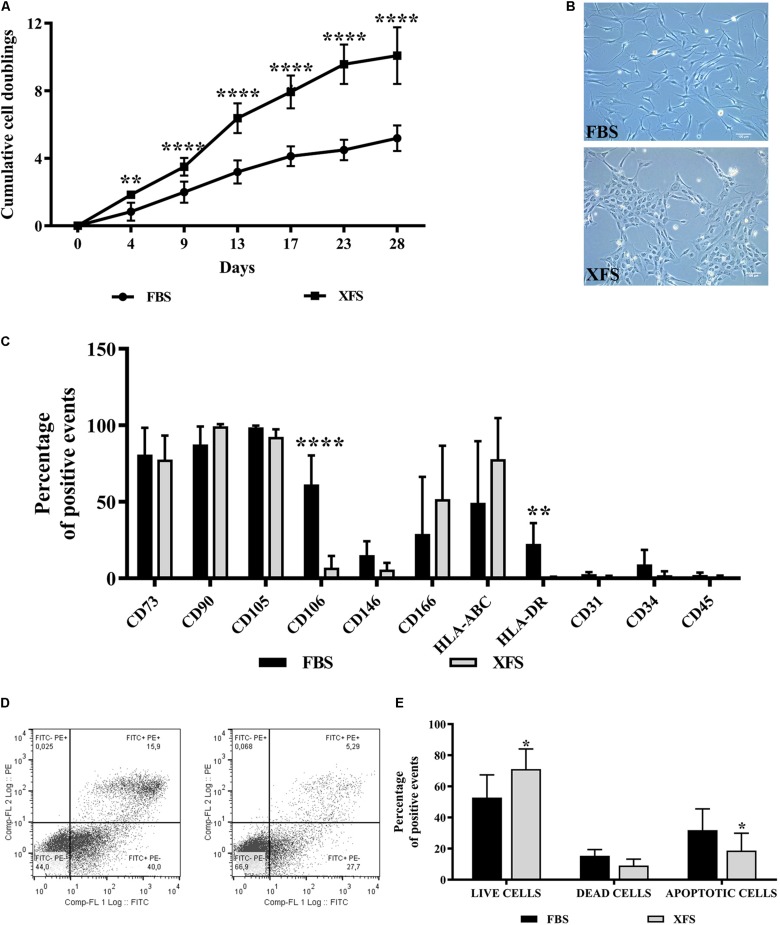
Characterization of hBMSCs cultured in FBS- or XFS-containing medium. (A) Proliferation of hBMSCs grown in FBS or XFS-containing medium (6 donors). Growth kinetics expressed as the cumulative number of cell duplications in relation to the culture time. **P < 0.01, ****P < 0.0001, t-test. (B) Microscope images showing the morphology of the cells. Images were acquired with a phase contrast Leica DMi1 microscope using a 10× magnification (scale bar 100 μm). (C) Flow cytometry analysis of hBMSCs cultured in the presence of FBS- or XFS-containing medium. The average percentage of positive events of each marker is reported in a histogram, indicating the mean ± SD of three independent experiments. **P < 0.01, ****P < 0.0001, t-test. (D) Detection of apoptosis by concurrent staining with FITC-anti-annexin V and PI of hBMSCs grown in FBS- (left panel) or XFS-containing medium (right panel). (E) Quantification of flow cytometry data. The histogram shows the mean ± SD of six independent experiments. *P < 0.05, t-test.